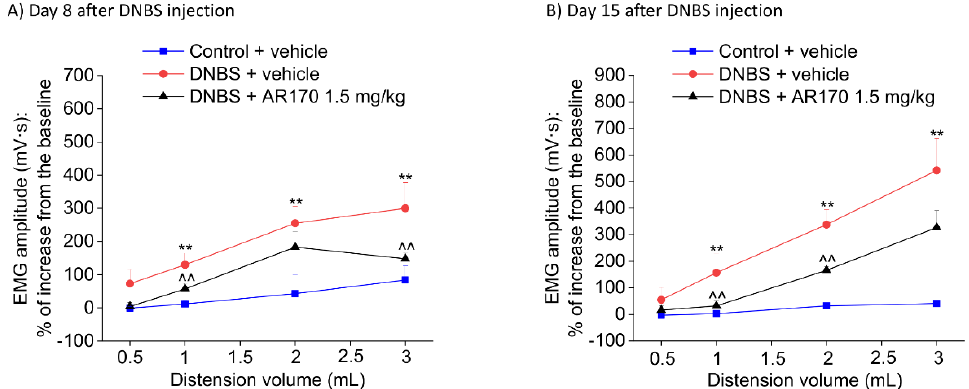
Figure 6. Visceromotor response (VMR) to the colorectal distension of DNBS-treated animals after the repeated administration of AR170 (1.5 mg/kg/day). The test was performed on day 8 ( A ) and 15 ( B ) after DNBS injection, 24 h after the last treatment. Control animals received the vehicle. Each value represents the mean ± S.E.M. ( n = 4). * p < 0.05 and ** p < 0.01 vs. the control + vehicle treated animals. ^ p < 0.05 and ^^ p < 0.01 vs. DNBS + vehicle treated animals.